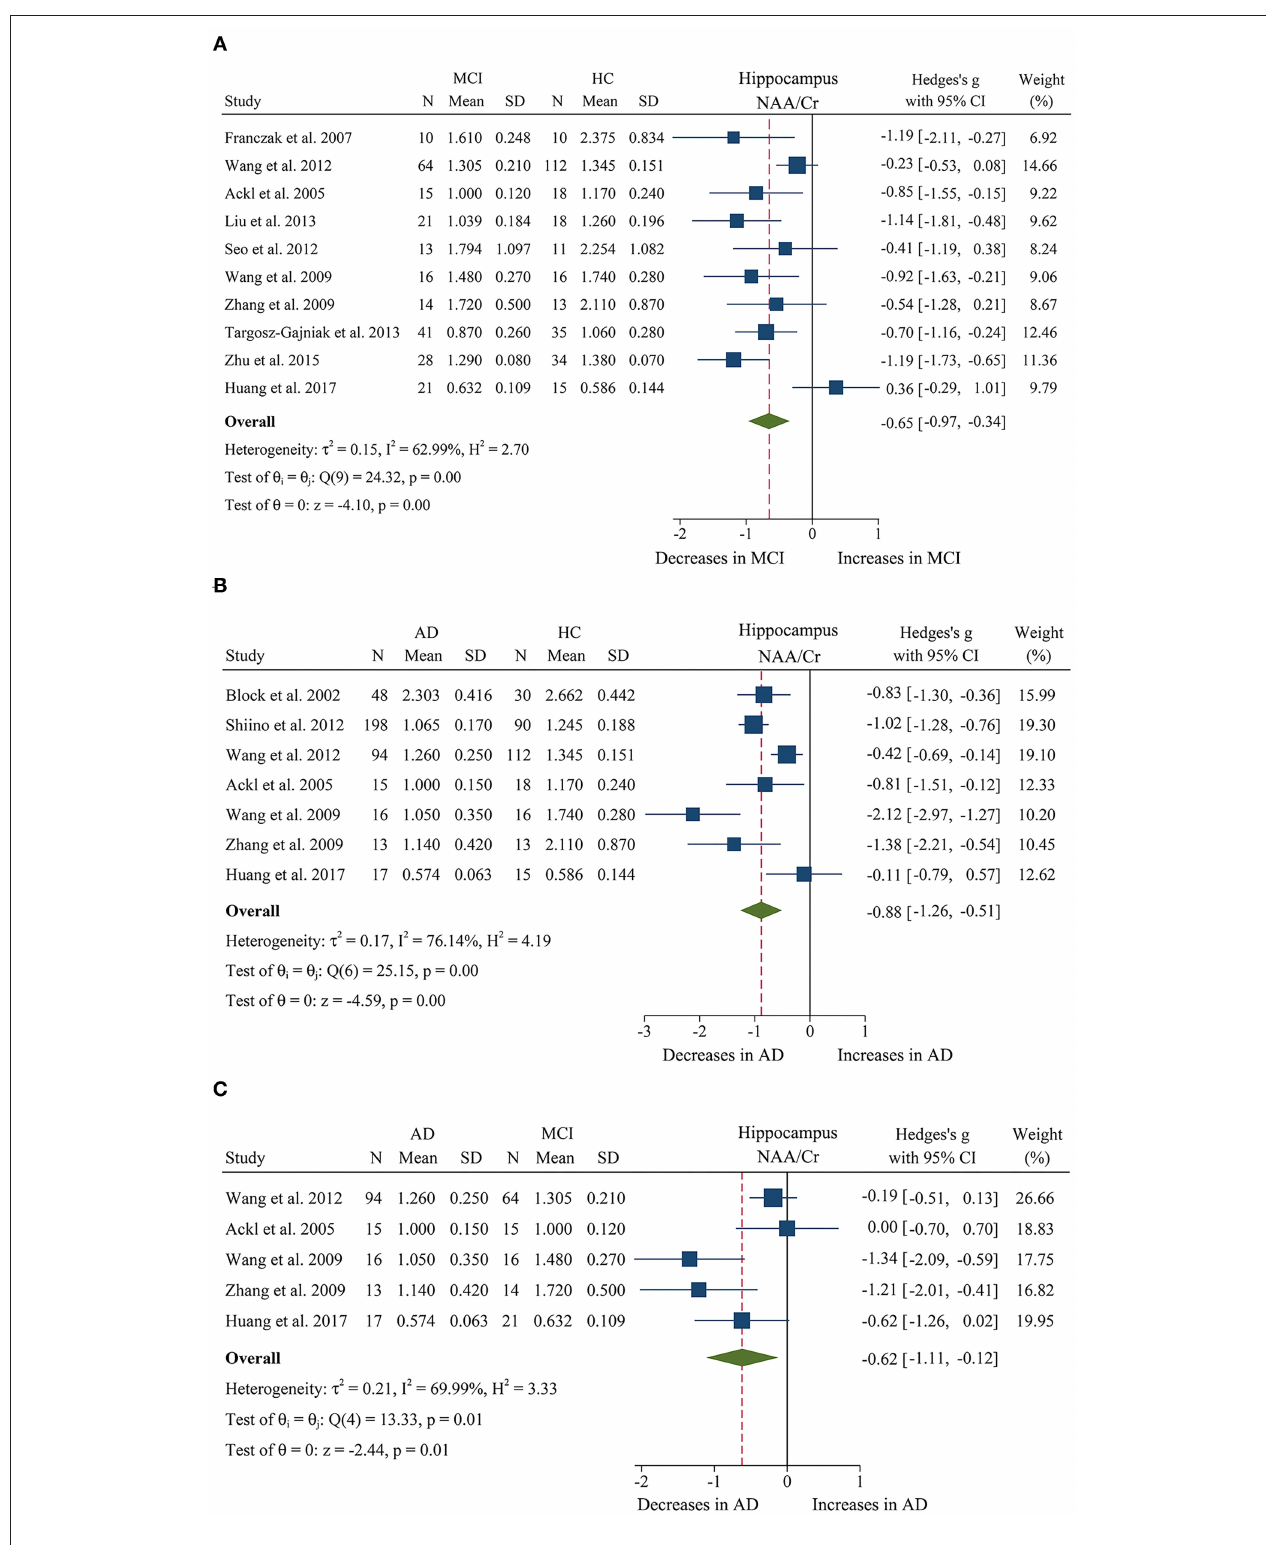
FIGURE 2 | Forest plots show the change of the ratio of NAA/Cr in the hippocampus between MCI, AD patients, and HC subjects. (A) Data include 525 individuals from 10 studies for meta-analysis of NAA/Cr levels between MCI and HC. (B) Data include 695 individuals from 7 studies for meta-analysis of NAA/Cr levels between AD and HC. (C) Data include 285 individuals from 5 studies for meta-analysis of NAA/Cr levels between AD and MCI.